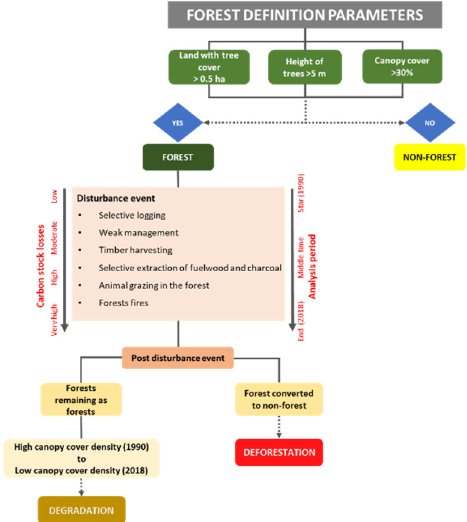
Figure 2. Main parameters and elements that interact in forest degradation in the Dominican